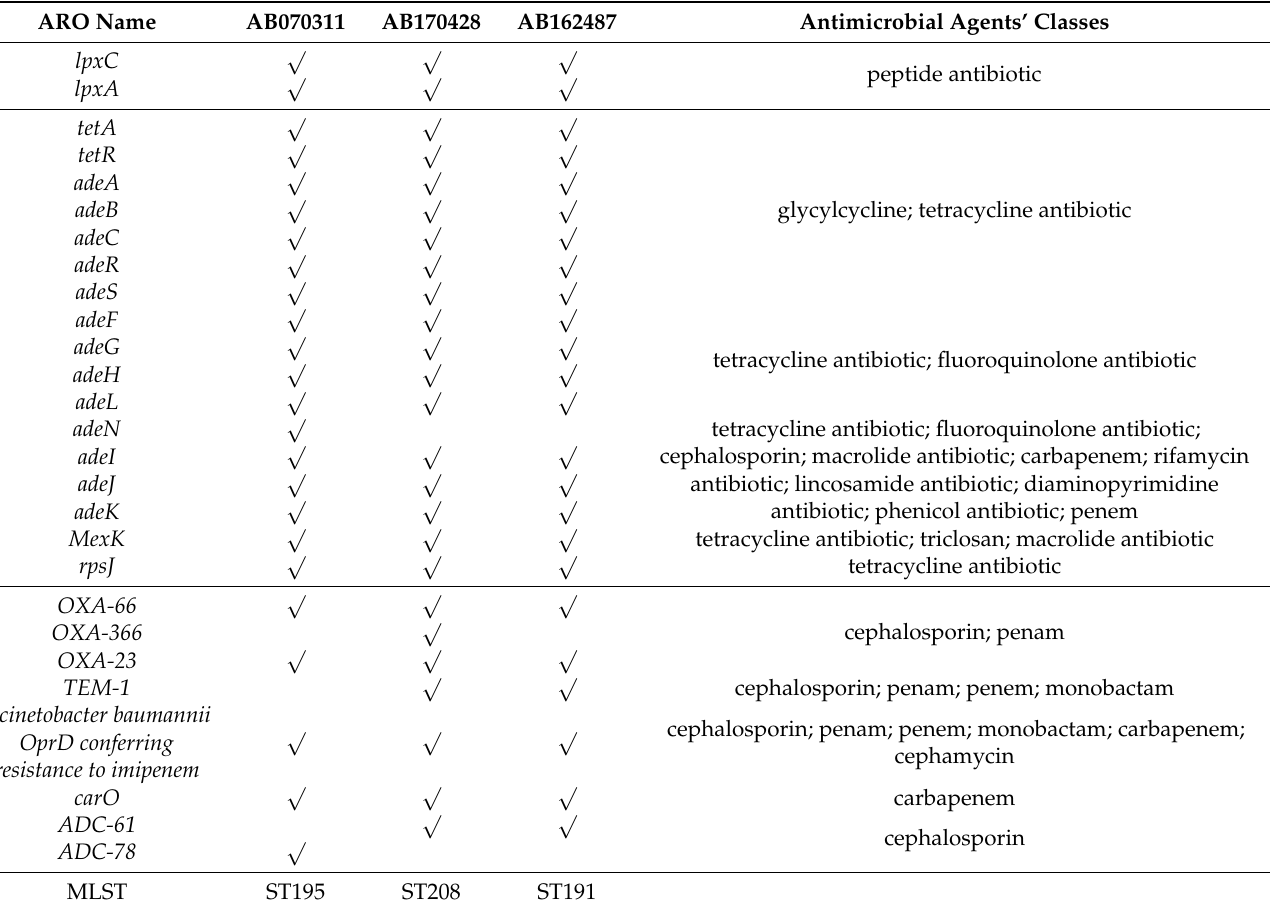
Table 1. Genetic information of tested CRAB strains.